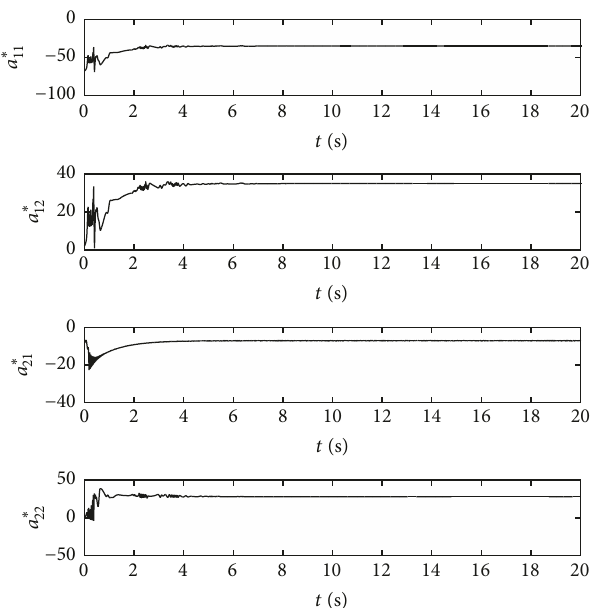
Figure 5: Estimated parameters of the Chen system finally evolve to the true values (𝑎 11 ,𝑎 12 ,𝑎 21 ,𝑎 22 ) = (−35,35,−7, 28) .